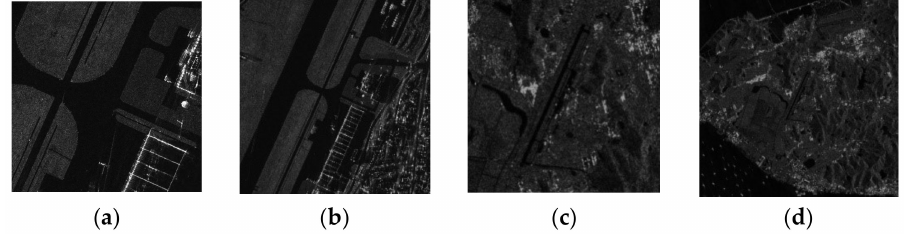
Figure 7. SAR image with scale difference: ( a ) Airborne SAR reference image. ( b ) Airborne SAR 3 × scale image. ( c ) Spaceborne SAR reference image. ( d ) Spaceborne SAR 3 × scale